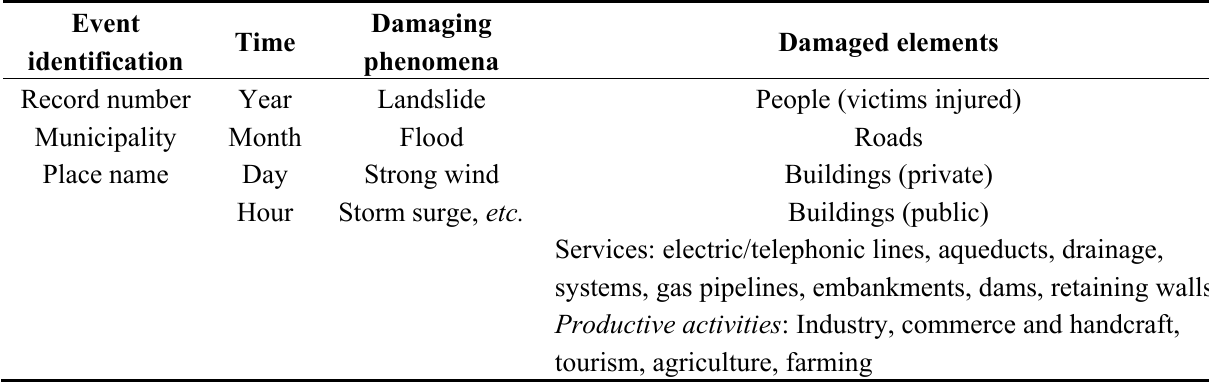
Table 1. Fields of the event